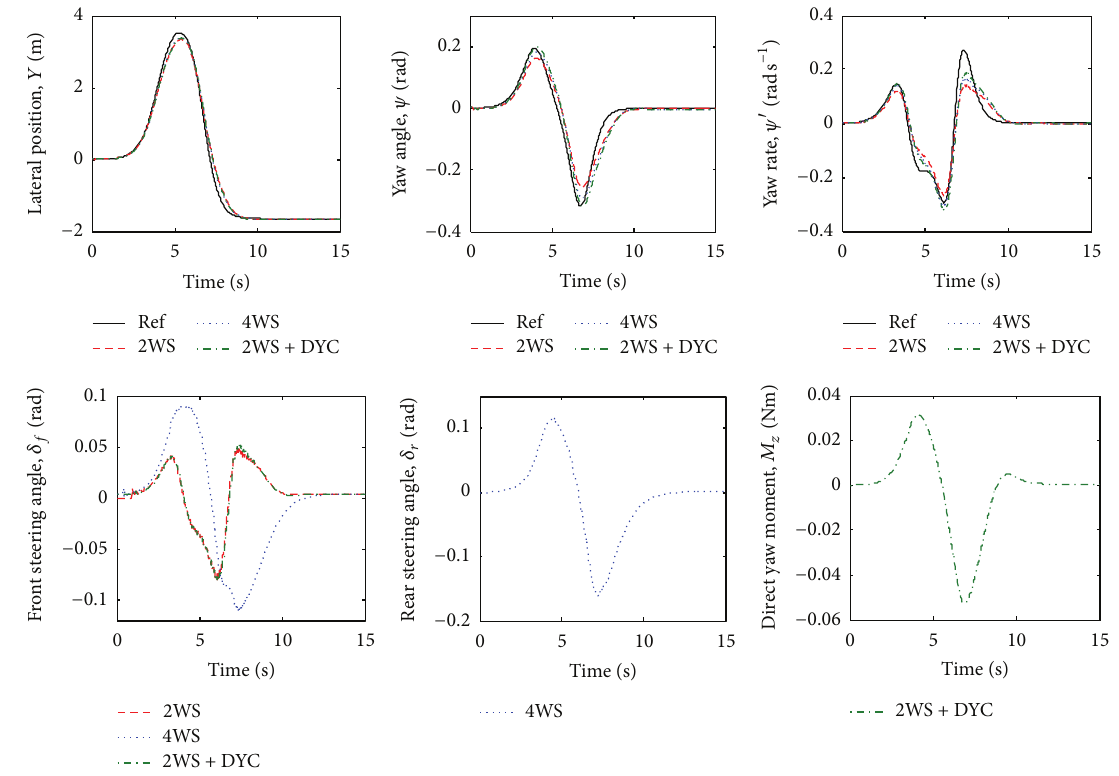
Figure 11: 3DoF controller at 10 ms −1 and 𝜇 = 0.1 by 2WS, 4WS, and 2WS + DYC. Table 5: Path following tracking errors with road friction surface 𝜇 =